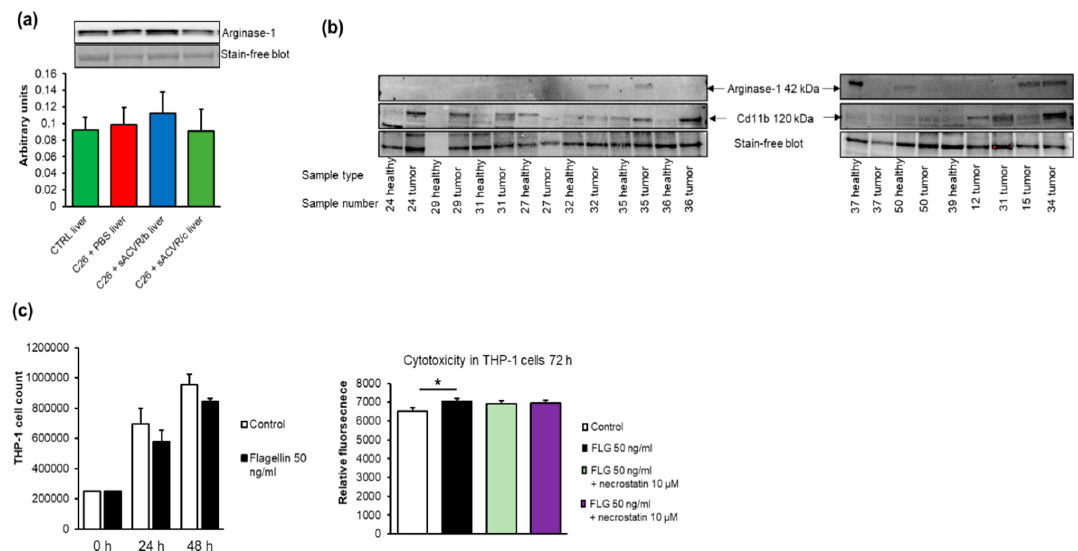
Figure 9. ( a ) In murine livers, no differences between the groups were found in the expression of M2-type macrophage marker Arginase-1. ( b ) Cd11b+ was found in 66% of the human tumors, with a greater prevalence in left-sided than right-sided tumors, and Arginase-1 was detected in 30% of the tumors. ( c ) Flagellin exposure started to decrease the number of THP-1 cells after 24 h, resulting in increased cytotoxicity at 72 h that was not affected by necrostatin. The blots were cut horizontally into two parts to analyze Arginase-1 and Cd11b from the same run. The original blots and the quantified intensities of the bands are provided in the Supplemental file. * Denotes a statistically significant difference between the groups that are connected with line. FLG = flagellin; control (CTRL, n = 9), cancer (C26 + PBS, n = 7), the group that received sACVR2B until tumor formation (C26 + sACVR/b, n = 7), and the group that received sACVR2B until death (C26 + sACVR/c, n = 8).